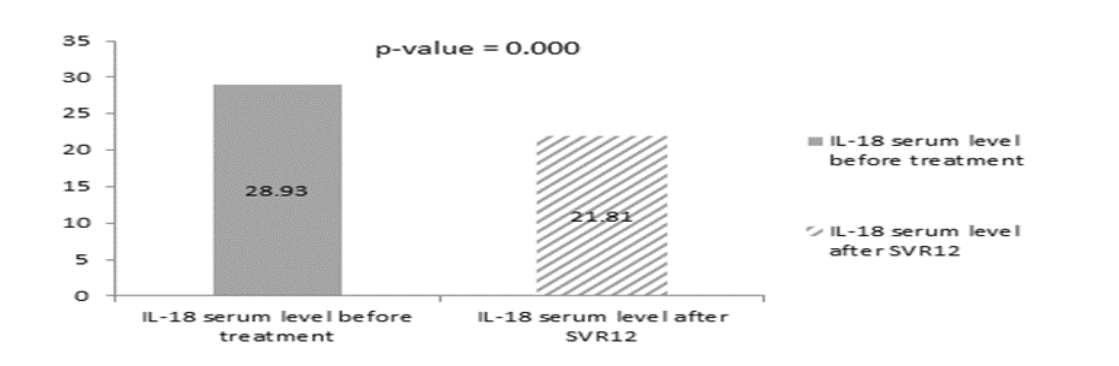
Figure 4. Showing comparison between IL-18 serum level before treatment and after SVR12 in chronic HCV patients. Data expressed as